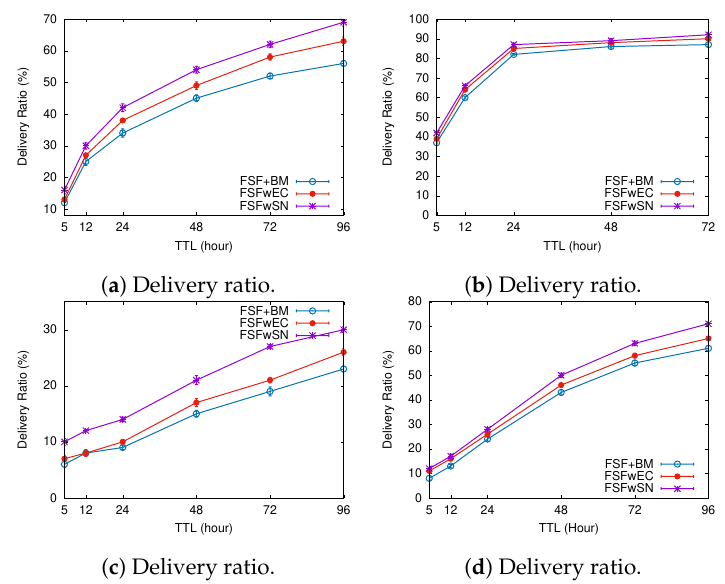
Figure 11. Delivery ratio when increasing the message TTL.